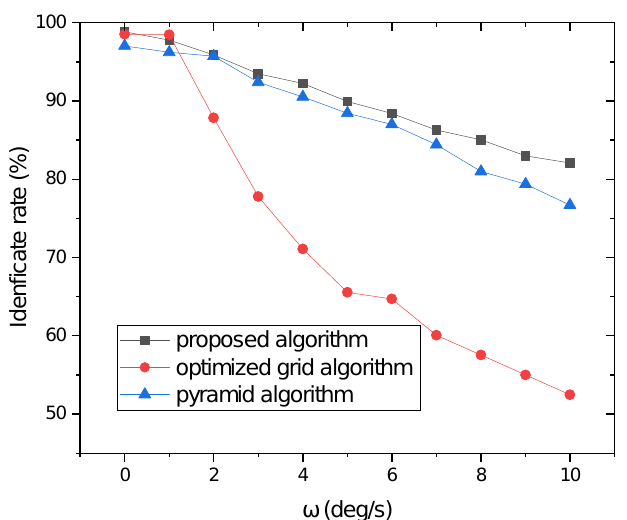
Figure 8. The effect of the rotation on the magnitude limit for star detection.